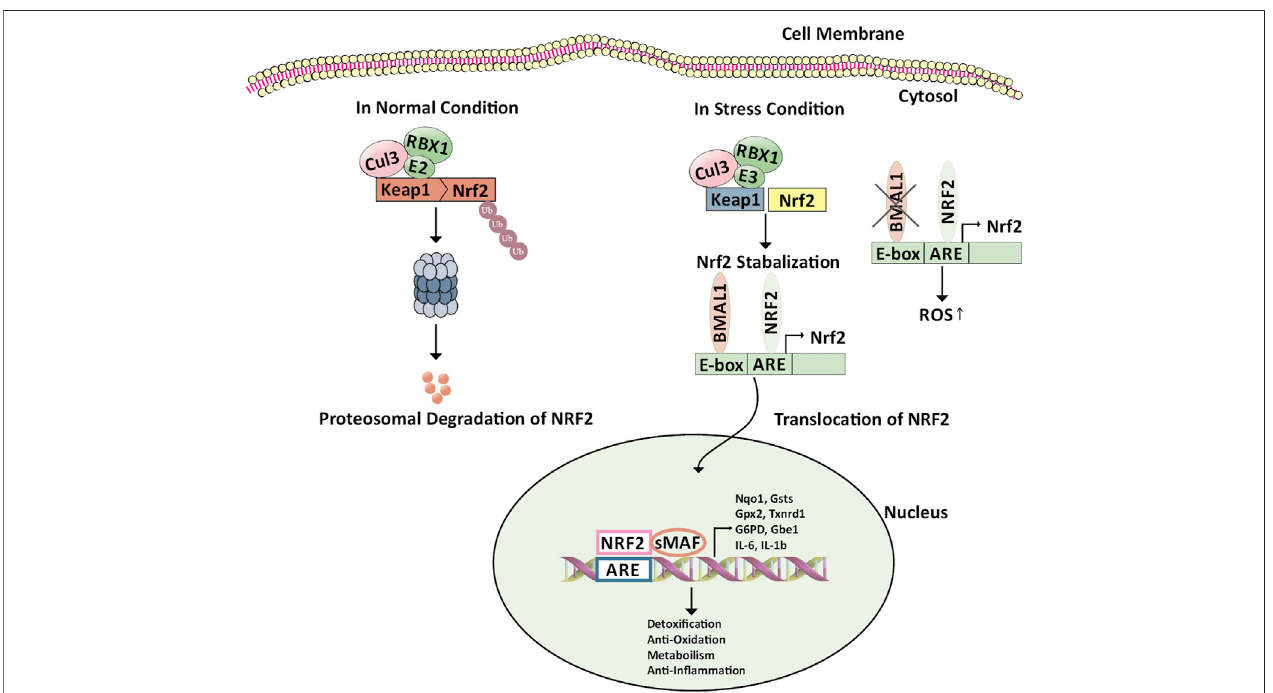
FIGURE2| Regulation ofKeap1/Nrf2/ARE pathway byBMAL1. Nrf2isconstitutively produced inthecell; however,in theabsenceofenvironmental stress,Nrf2is sequestered in the cytoplasm by binding to an inhibitory protein, Keap1, which promotes continuous ubiquitinylation. Keap1 serves as a bridge between Nrf2 and the Cul3-Rbx1 E3ubiquitin ligase. Cellular stressleadstomodi fi cation ofreactive cysteines withinKeap1 that induces conformationalchangesresulting inNrf2stabilization. Here BMAL1 binds to the antioxidant response element through the E-box element present on the Nrf2 promoter leading to the transcription of Nrf2 and stabilization of the same. The NRF2 protein then translocates into the nucleus. There, it forms a heterodimer with other transcription regulators, such as small Maf proteins. The NRF2-sMaf complex binds to the ARE-containing genes in the nucleus involved in detoxi fi cation, anti-oxidation, anti-in fl ammation, and metabolism. The de fi ciency of BMAL1 disrupts the circadian rhythm of the Nrf2 pathway leading to cellular damage. Abbreviations: ARE, Antioxidant response element; BMAL1, Bone Muscle Arnt-like protein-1; Cul3-Rbx1 E3 ubiquitin ligase, Cullin 3-Ring box1 E3 ubiquitin ligase; E-box, Enhancer Box; G6pd, Glucose-6-phosphate Dehydrogenase; Gpx2, Glutathione Peroxidase 2; Gsts, Glutathione S-Transferase; IL-6, Interleukin-6; IL-1b, Interleukin 1 beta; Keap1, Kelch-like ECH-associated protein 1; NRF2, Nuclearfactorerythroid2-relatedfactor2;Nqo1,(NAD(P)HQuinoneDehydrogenase1);sMaf,Smallmusculoaponeurotic fi brosarcoma;Txnrd1,ThioredoxinReductase 1; Ub,